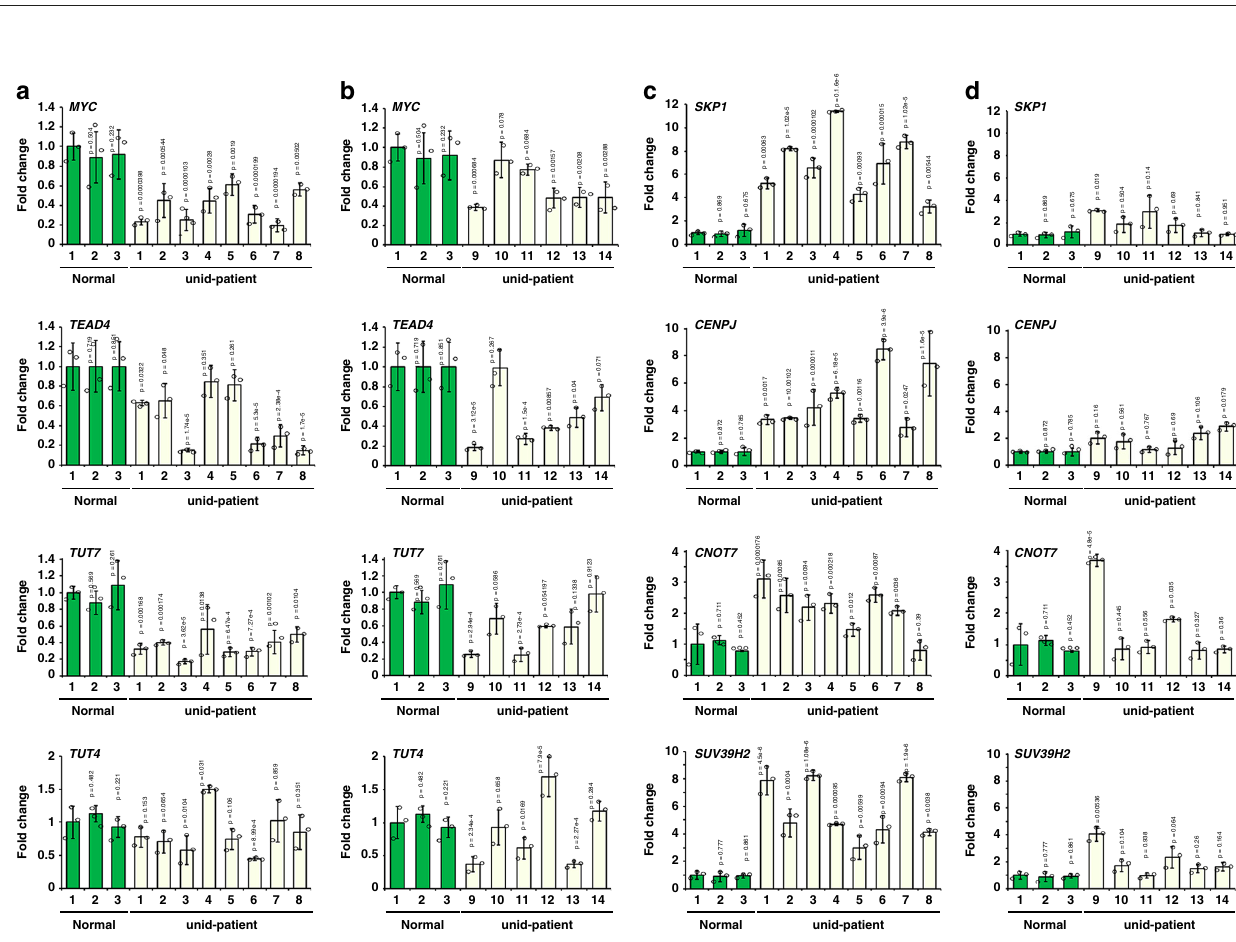
Fig. 8 Transcriptome changes in 8-cell stage-arrested human embryos. a The illustration shows the collection of human embryos to perform RNA-seq. Zygotes obtained by IVF were cultured to the 8-cell or blastocyst stages. b Representative images of morphologically normal and 8-cell stage-arrested embryos. Scale bars = 50 µ m. c The PCA results of embryos at the indicated stages. Arrested 8-cell embryos that were derived from unidenti fi ed patients were in vitro fertilized and cultured for 5 days before RNA isolation. 1 – 6, represent embryos from different unid-patients. All observed normal ( n = 3) and arrested embryos ( n = 14) looked like this in three independently repeated observations. d and e are derived from unid-patients (#1,4 – 6) to that of normal 8-cell embryos. Transcripts decreased or increased by more than 2 folds d or 5 folds e in arrested embryos compared to normal embryos, which were highlighted in blue or red, respectively. n , gene number; FC fold change. f Venn diagrams show the overlap of down-regulated transcripts in arrested embryos and ZGA transcripts in normal embryos. P = 1e − 410 by a two-tailed Student ’ s t -test. g Venn diagrams show the overlap of up-regulated transcripts in arrested embryos, the degraded transcripts from the zygote stage to the 8-cell stage in normal embryos, and ZGA-dependent Z-decay transcripts during normal MZT. P = 1e − 14 by a two-tailed Student ’ s t -test. h A heatmap illustration shows differentially expressed transcripts in normal and arrested embryos. Group A, transcripts that are degraded (fold change >2) during the zygote-to-8-cell transition in normal embryos, but that remained stable in the arrested 8-cell embryos. Group B, transcripts that signi fi cantly increased (fold change > 2) from the zygote stage to the 8-cell stage in normal embryos, though not in arrested 8-cell embryos. i and j Gene ontology analysis of the transcripts of Group A i and Group B j .